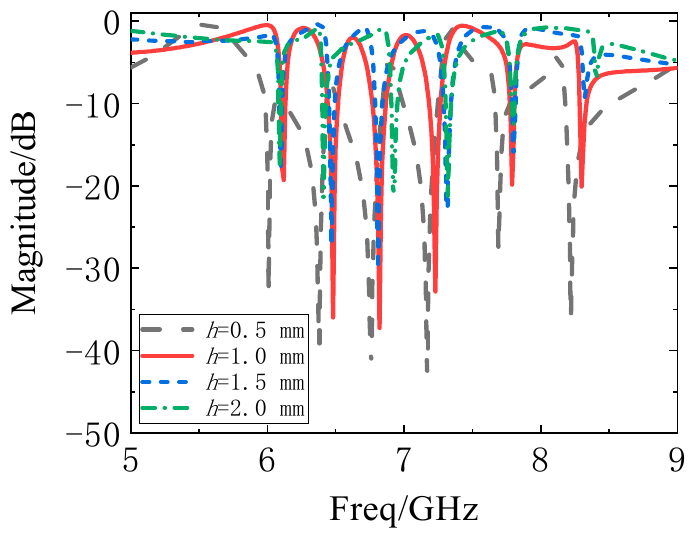
Figure 17. Resonance curves of U-shaped slot resonator with different substrate thickness. Figures 18 and 19 show the resonance curves of the resonator with the longest side